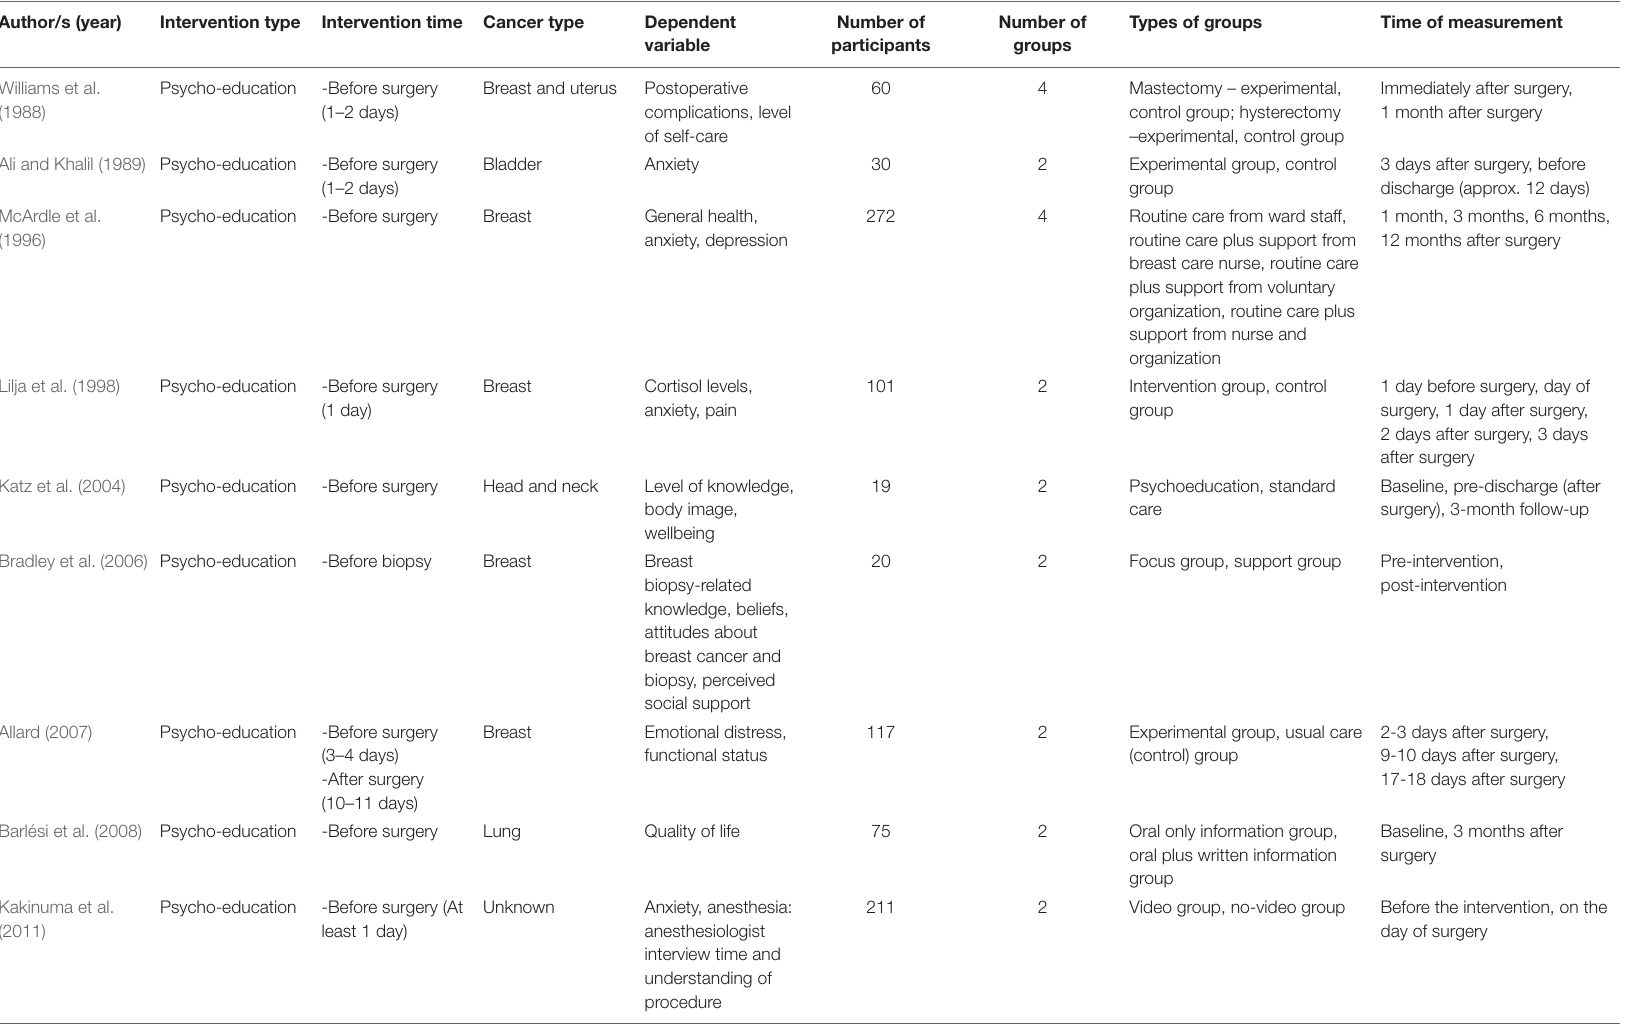
TABLE 1 | Studies organized by intervention